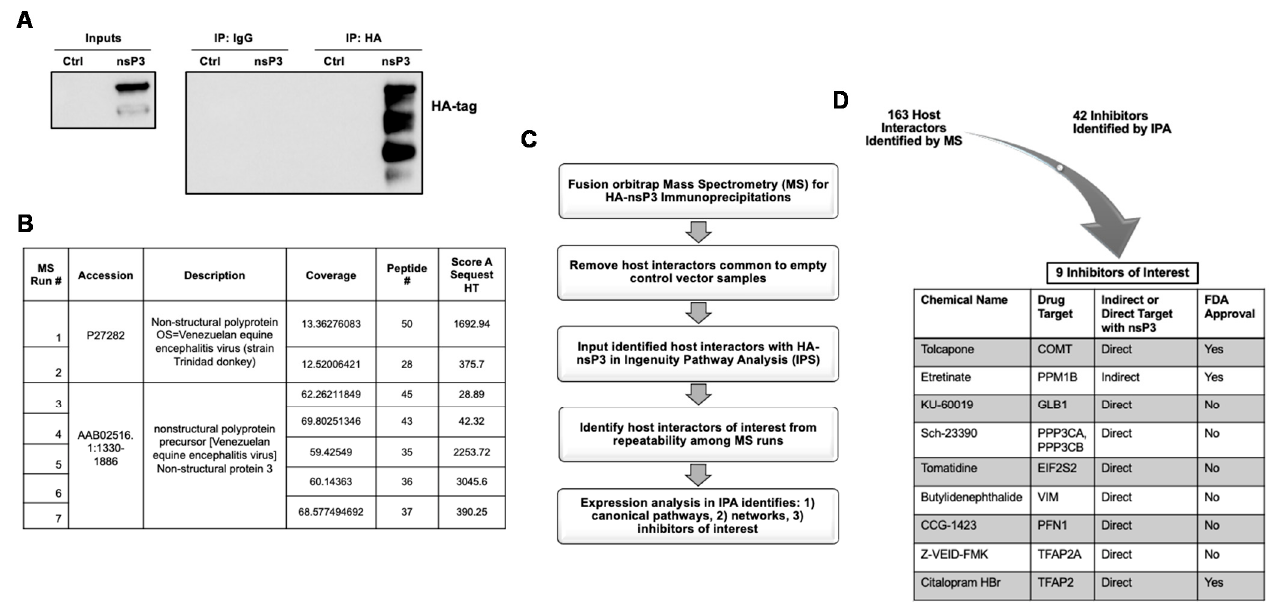
Figure 1. Mass spectrometry identified putative host interactors with VEEV nsP3 and potential antivirals. Then, 293T cells were transfected with a pcDNA 3.1 (+) empty control plasmid or a pCAGGS plasmid expressing N-terminus HA-tagged nsP3 of the ZPC738 VEEV strain. Next, 24 hpt, lysates were subjected to immunoprecipitation with anti-HA tag antibody or IgG3 isotype control antibody. Expression and immunoprecipitation of HA-nsP3 was confirmed by Western blot ( A ) and six independent immunoprecipitated samples were subjected to Fusion Orbitrap mass spectrometry ( B ), as described in Materials and Methods. Western blot and immunoprecipitations are representative of six independent experiments ( n = 6). Mass spectra were fitted against the NCBI reference sequence AAB02516 or P27282 for the non-structural polyprotein of VEEV. ( C ) Schematic of data analysis by Ingenuity Pathway Analysis. Host proteins identified by mass spectrometry runs were analyzed for abundancy and identification of canonical pathways, networks, and inhibitors. ( D ) A list of small molecule inhibitors were identified using IPA for efficacy studies.